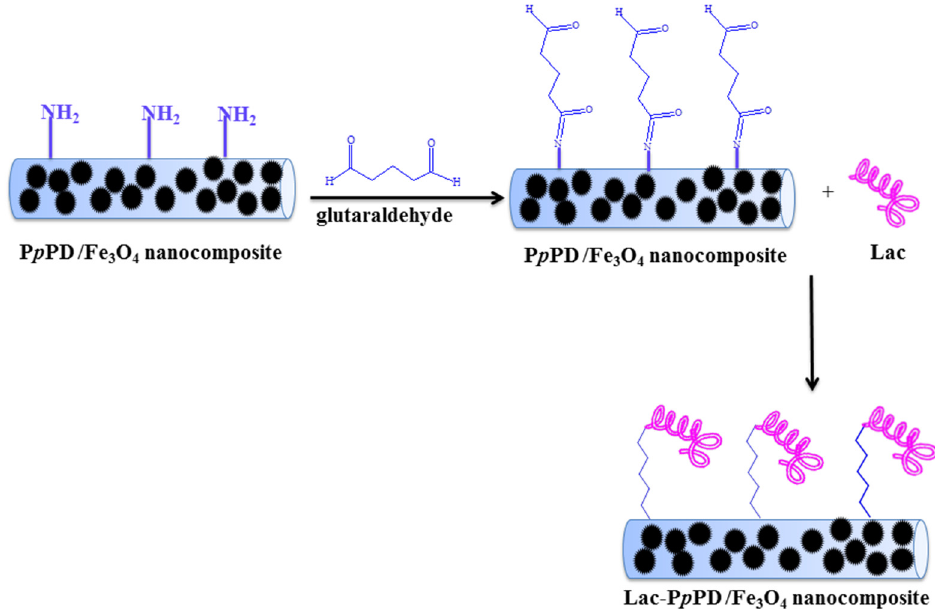
Figure 4. Schematic illustration of Lac immobilization on P p PD/Fe 3 O 4 nanocomposite.